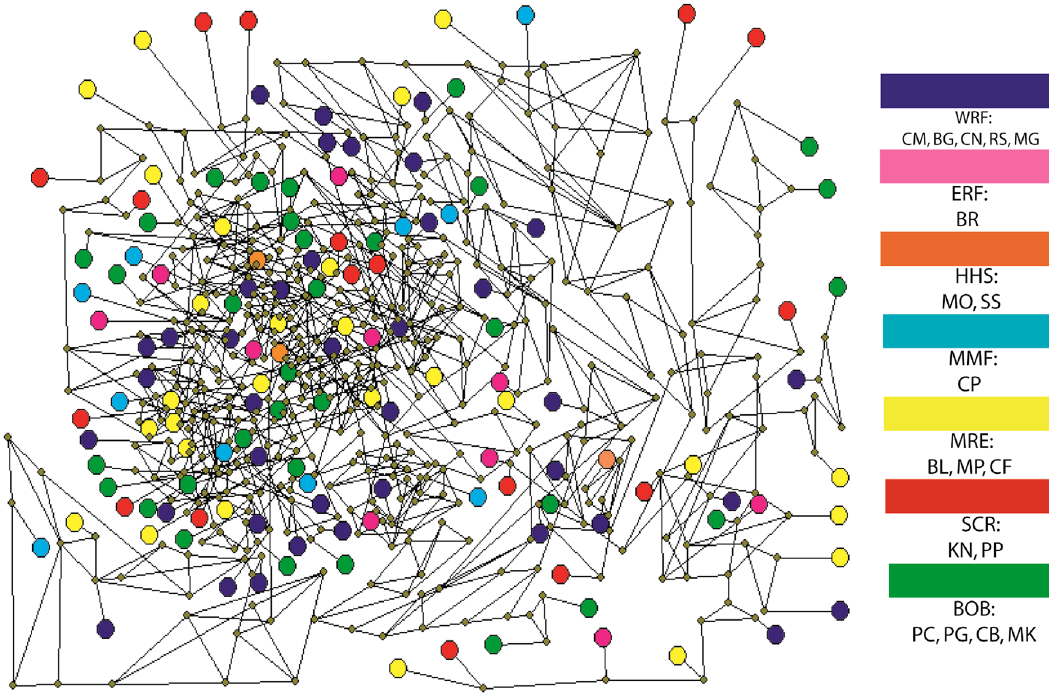
Figure 4. A median joining network of studied individuals based on 842 SNP loci by Network 5.0.1.1 (https:// www. fluxus- engin eering. com/ share net_ rn. htm). Each color indicates specific habitat group and abbreviated letter indicates sampling location. CM, Chilmari; BG, Balashi Ghat; CN, Chapai-Nababganj; RS, Rajshahi; MO, Mohanganj; SS, Someshwari, Durgapur; MG, Manikganj; BR, Bhairab; CP, Chandpur ; KN, Khulna; PP, Pirojpur; BL, Bhola; MP, Mohipur; CF, Char Fasson; PC, Pokhkhir Char; PG, Patharghata; CB, Cox’s Bazar; MK, Maheshkhali. Source of variation d.f Sum of squares Variance components Percentage of variation Among